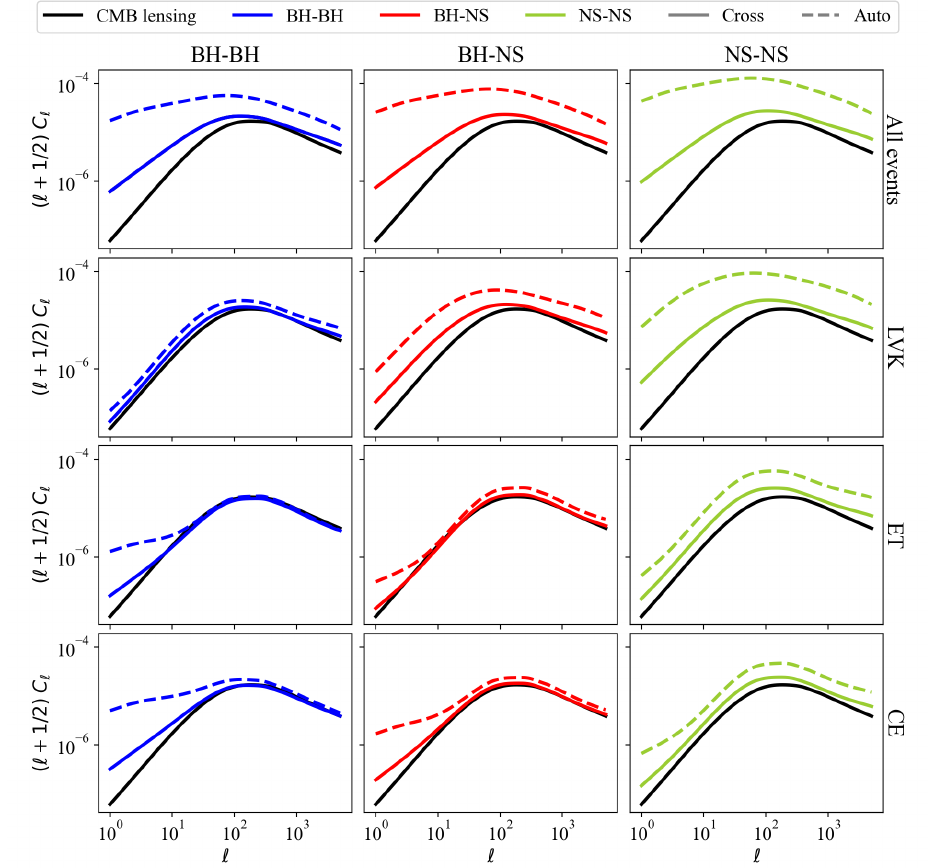
Figure 2. Auto- and cross-correlation angular power spectra for SGWB and CMB lensing convergence anisotropies. Each panel displays the SGWB auto-correlation angular power spectrum (dashed) and the SGWB × CMB convergence cross-correlation angular power spectrum (solid) for given source (BH-BH, BH-NS or NS-NS) and detector (LIGO/Virgo/KAGRA, ET, CE or no detector, i.e., all events considered) and the convergence auto-correlation angular power spectrum for reference.